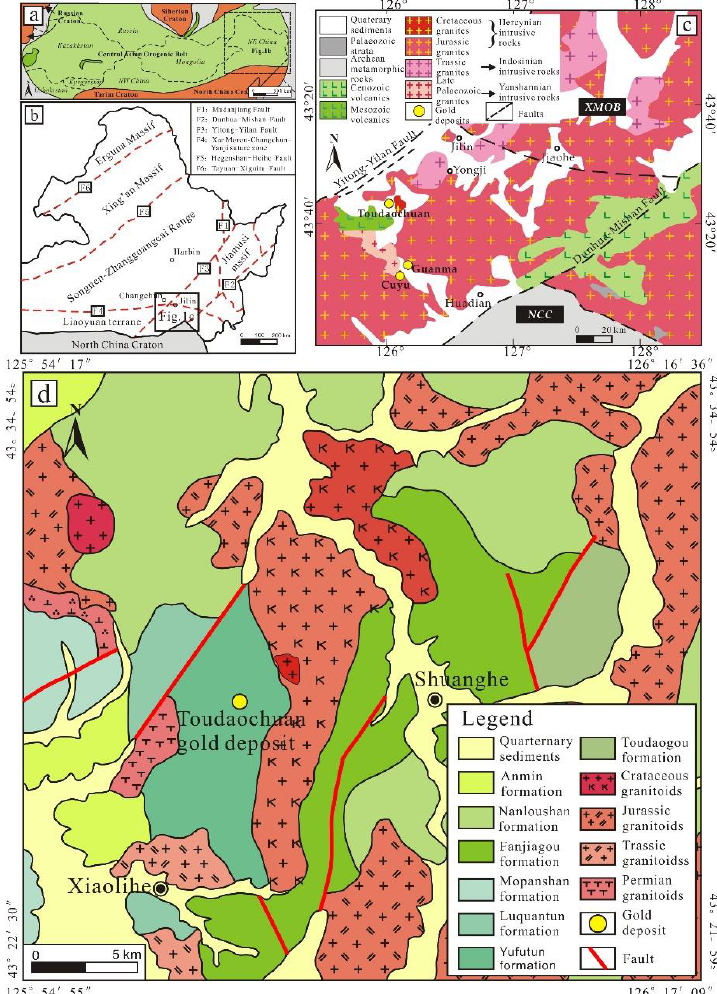
Figure 1. ( a ) Simplified tectonic map of the CAOB (after Safonova and Santosh [16]). ( b ) Tectonic divisions of the NE China (after Wu et al. [18]). ( c ) Geological map of the central Jilin Province, showing some representative gold deposits (after Yang et al. [19]). ( d ) Detailed geological map of the study area (after JBGMR [20]).